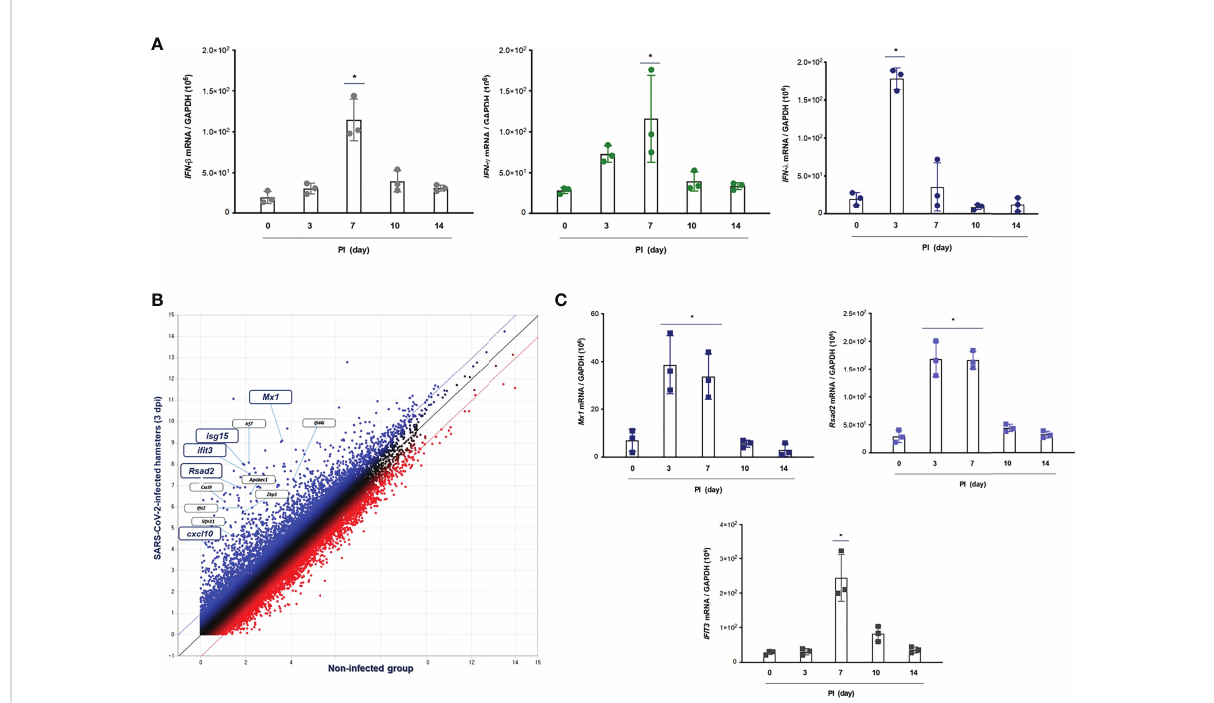
FIGURE 3 IFN-related immune responses in the lung of CoV2+ hamsters. Syrian golden hamsters were used in these experiments. The hamsters were infected with SARS-CoV-2 (BetaCoV/Korea/SNU01/2020, 2.5 × 10 5 TCID50/hamster) at the indicated time points (N = 3 at the indicated time points). (A) The transcriptions of IFN- b , IFN- g , and IFN- l 2/3 were determined in the lungs of SARS-CoV-2-infected hamsters at 0, 3, 7, 10, and 14 dpi. (B) The scatter plot data showed DEGs associated with “ response to IFNs ” in the lungs of SARS-CoV-2-infected hamsters at 3 dpi. (C) Mx1 , Rsad2 , and I fi t3 mRNA levels were determined in the lungs of hamsters in response to SARS-CoV-2 infection at 0, 3, 7, 10, and 14 dpi. Real-time PCR results are analyzed by Mann – Whitney U test and presented as mean ± SD values from three independent experiments. * p < 0.05 vs. non- infected